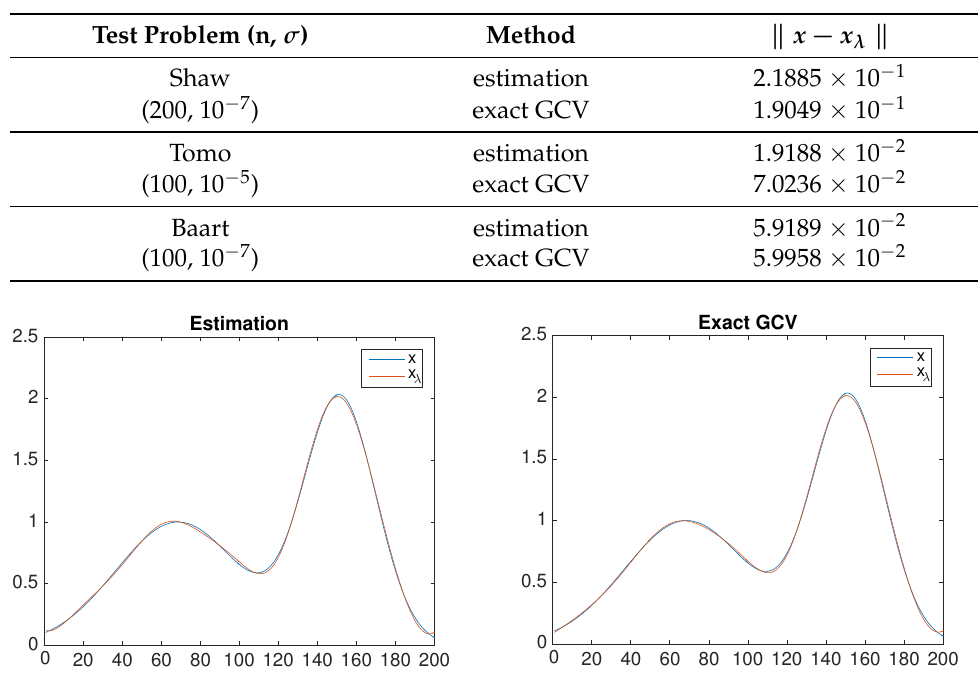
Table 6. Characteristics of Figures 1–3.